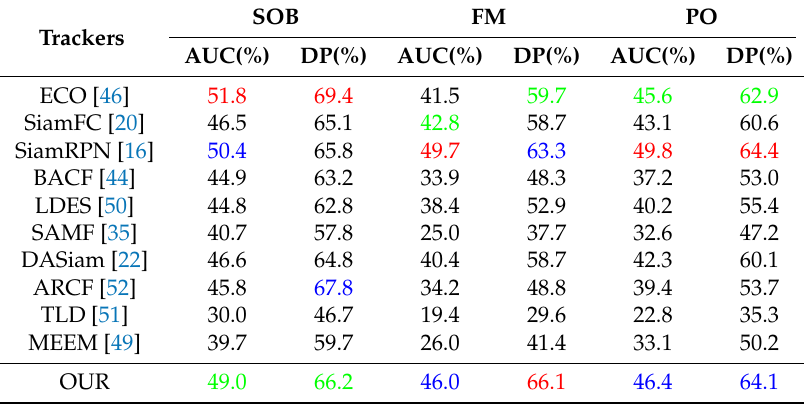
Table 3. Performances comparison of different trackers in cases of Similar Object (SOB), Fast Motion (FM) and Partial Occlusion (PO). The distance precision (DP) is threshold scores at 20 pixels, and the AUC is the area under the success rate curve score. The red, blue, and green colors represents the first, second, and third